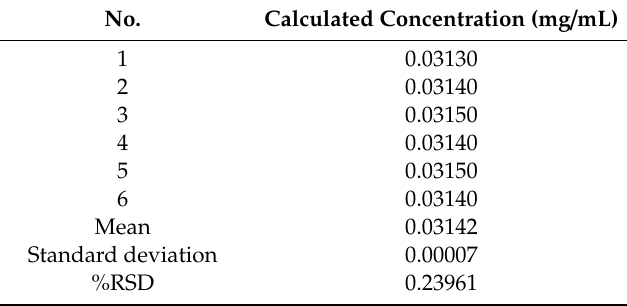
Table 2. Determination of repeatability by six replicate and analysis using qNMR.